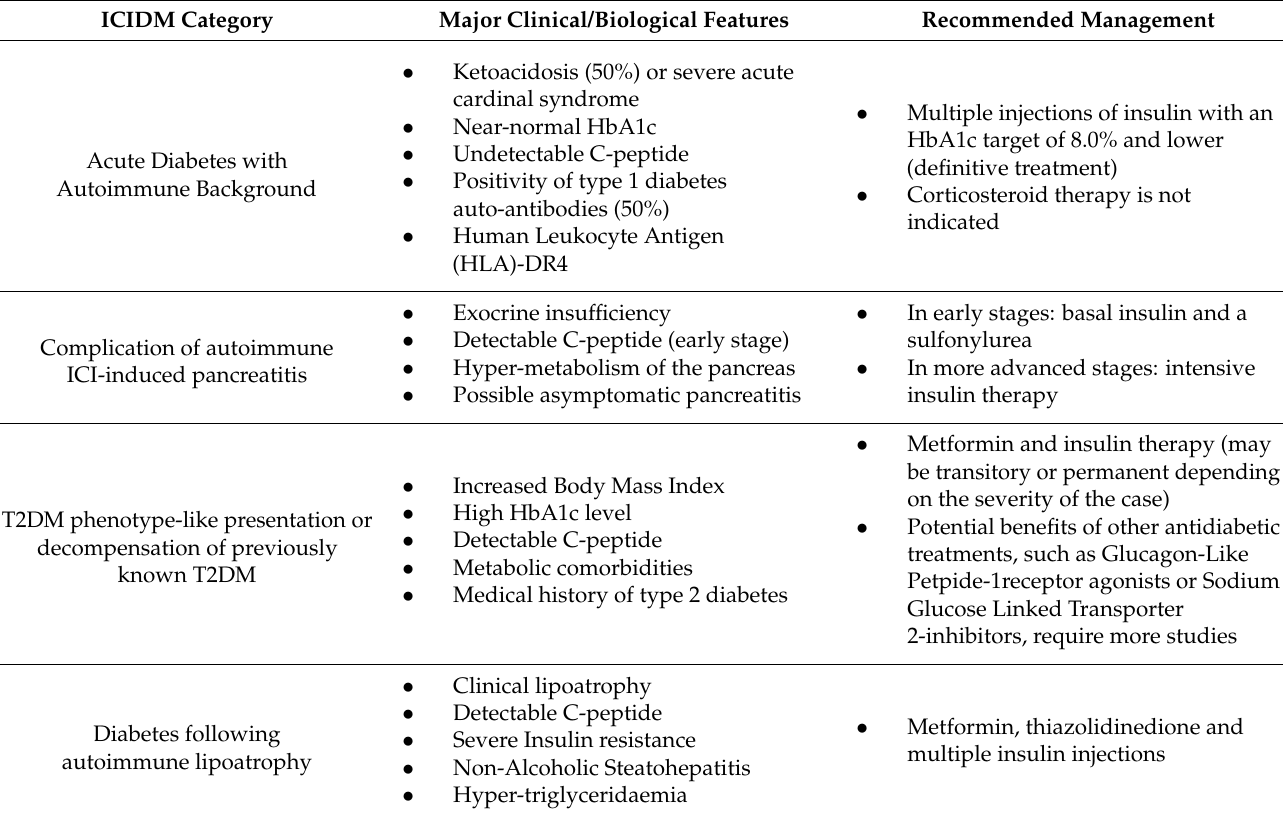
Table 2. Major clinical/biological features and recommended management of different categories of ICI-induced diabetes mellitus (ICIDM) [9,10]. ICIDM